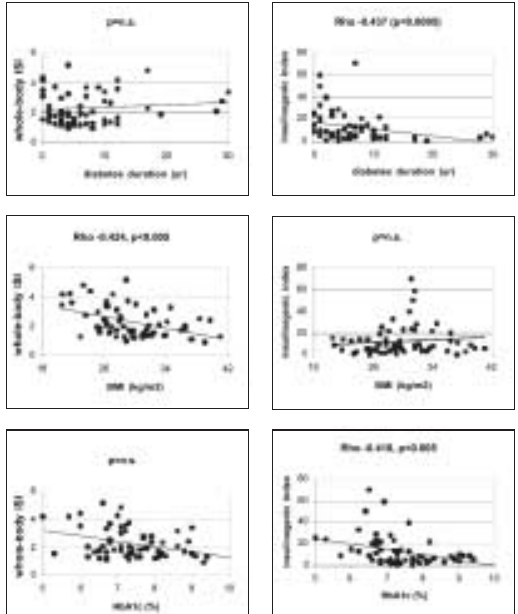
Patients with type 2 diabetes. Spearman rank correlation for whole-body insulin sensitivity index (ISI) and insulinogenic index with duration of diabetes, BMI, and HbA 1c in 65 patients with type 2